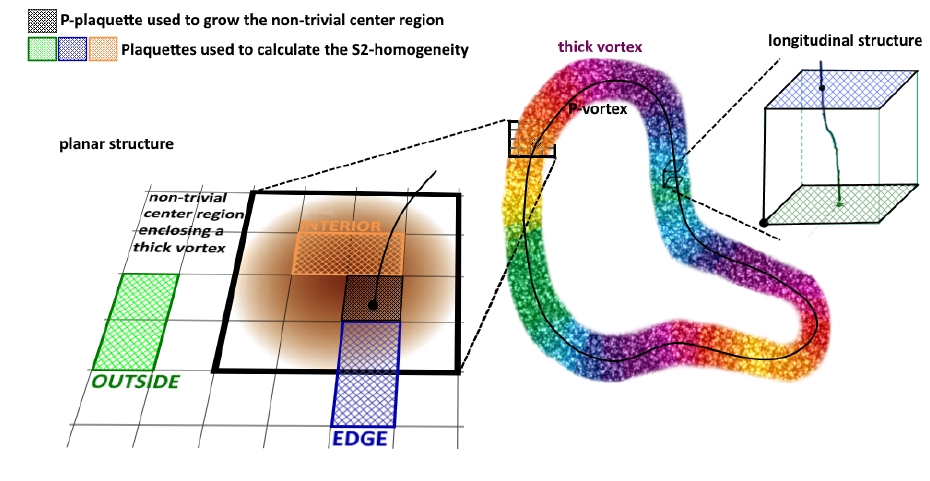
Figure 8. The colorful thick line in the middle of the figure represents flux building a thick vortex and the black thin line in its center indicates the fluxline of the corresponding P-vortex. On the non-projected field configuration this vortex is detected by the non-trivial center region, surrounded by a black rectangle on the original lattice in the left diagram. We investigate the S2-homogeneity on the pairs of plaquettes, outside the vortex, inside the vortex and on its edge, indicated there by shaded regions. With pairs of non-planar plaquettes, depicted in the right diagram, an analysis of the longitudinal color structure is